Question: What style of plot is this figure drawn as?
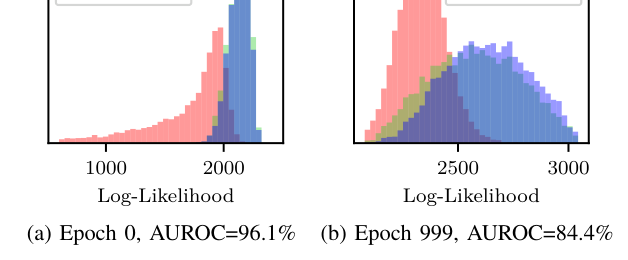
Answer: histogram